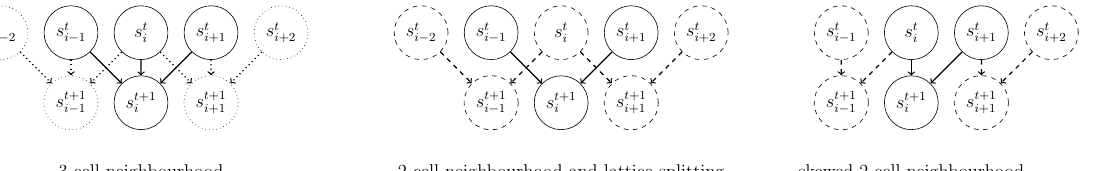
Figure 6. Decoupling of the lattice and skewed